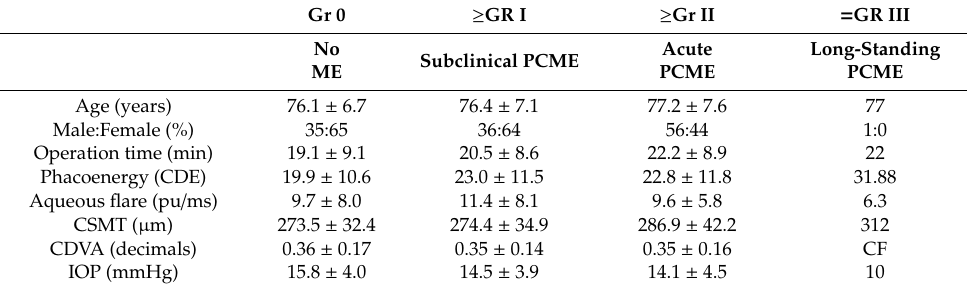
Table 2. Baseline (preoperative) parameters according to the PCME classification.